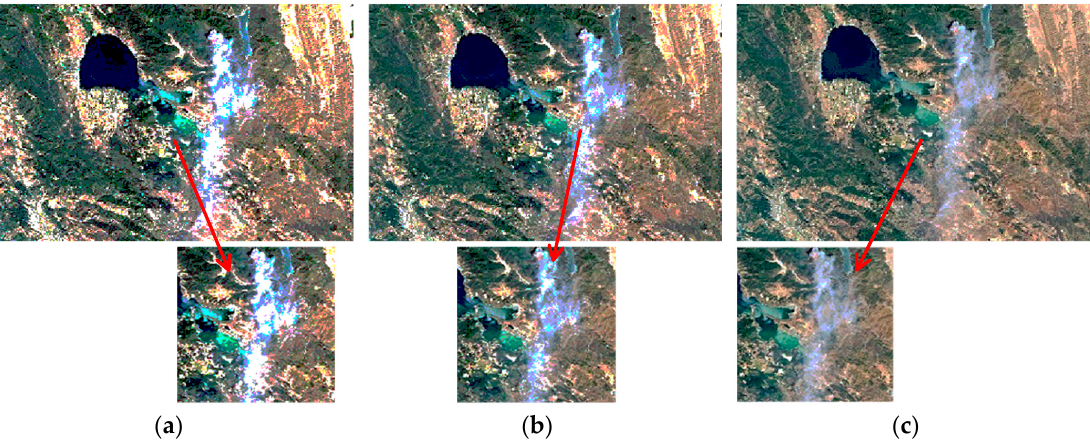
Figure 6. The segmented results and local zoom maps of “Image7” at 4, 8, and 12 threshold levels. ( a ) K = 4, ( b ) K = 8, ( c ) K = 12.